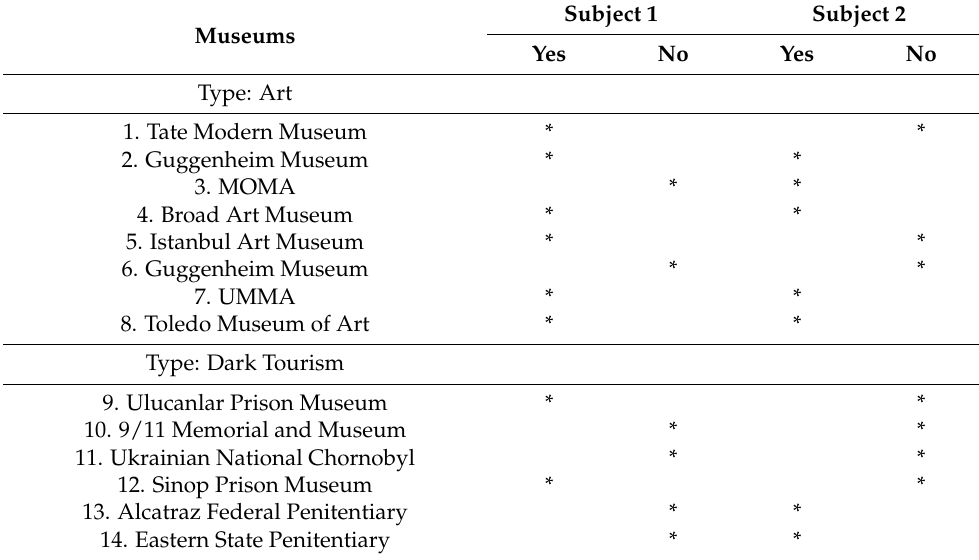
Table 1. Summary of museums included in this